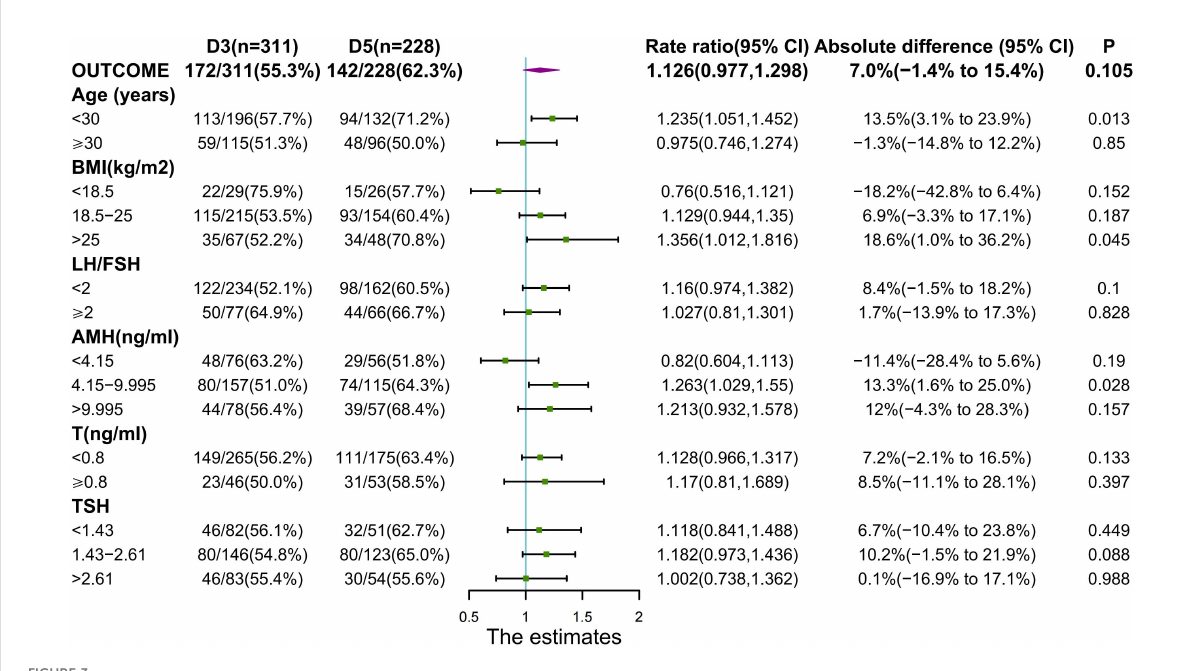
FIGURE 3 Outcomes with Regard to Live Birth